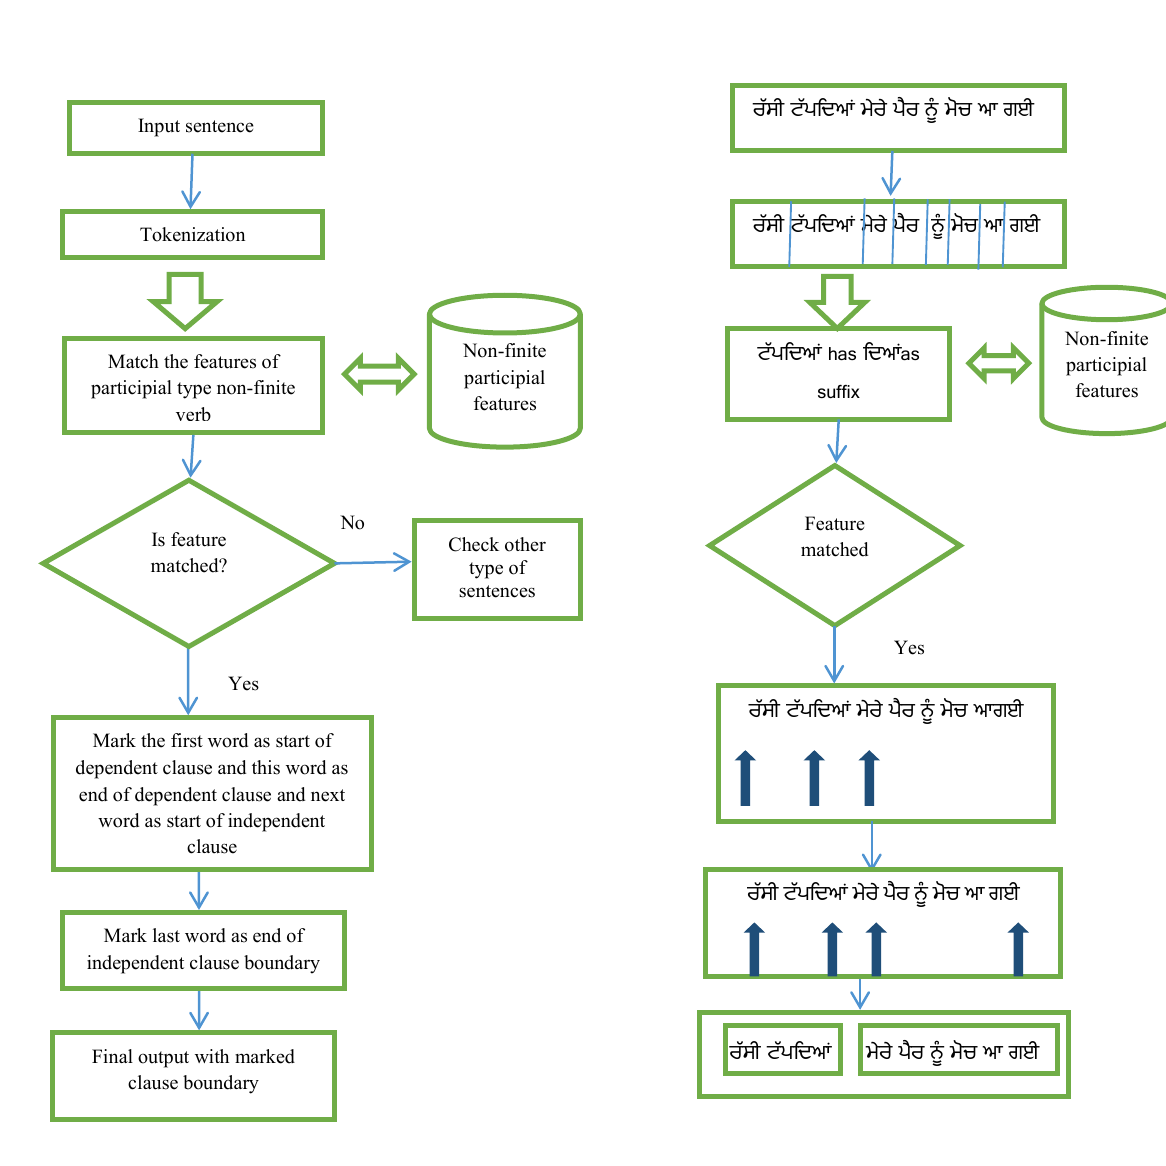
Figure 2. Flow chart and working example to mark clause boundary in participial type complex sentences